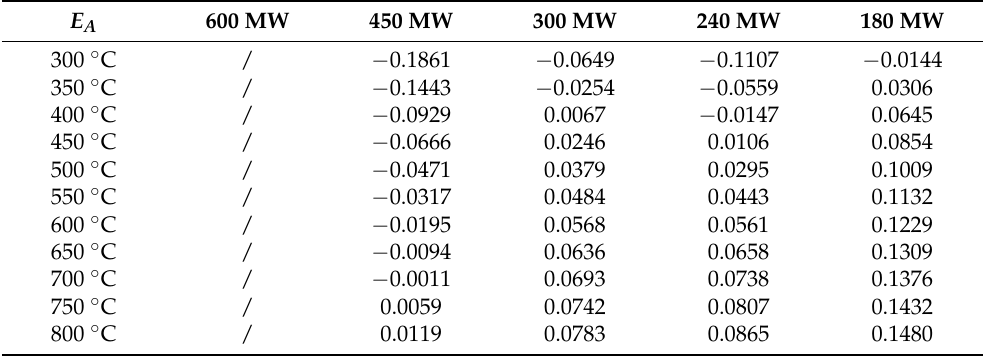
Table 6. Sensitivity analysis of unit